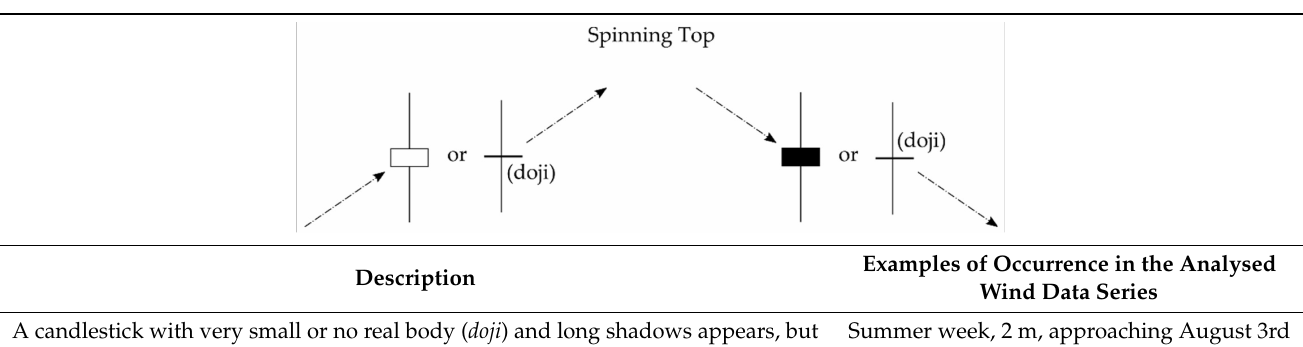
Examples of Occurrence in the